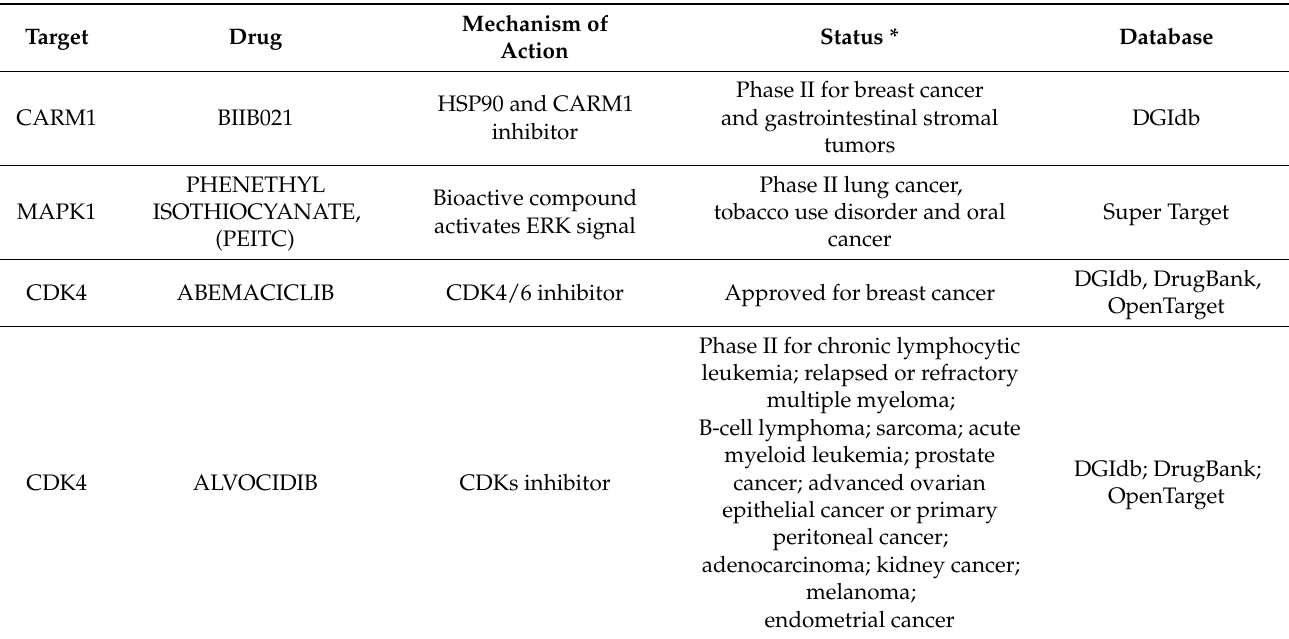
Table 1. Repurposable candidates for oxidative-stress phenotype in MS. The table shows drug candidates with their mechanism of action and clinical trial status for each target. The queried databases are also